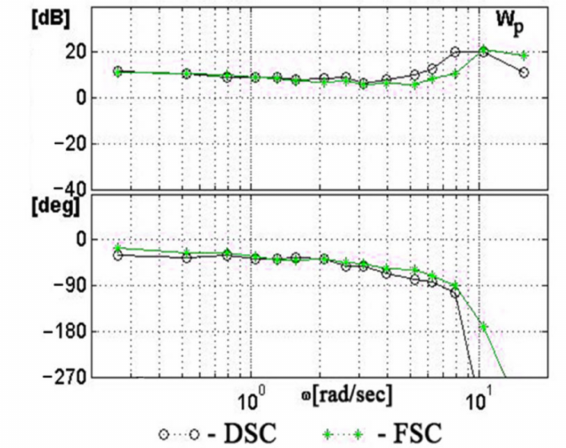
Figure 15. Pilot describing functions for DSC and FSC pilot